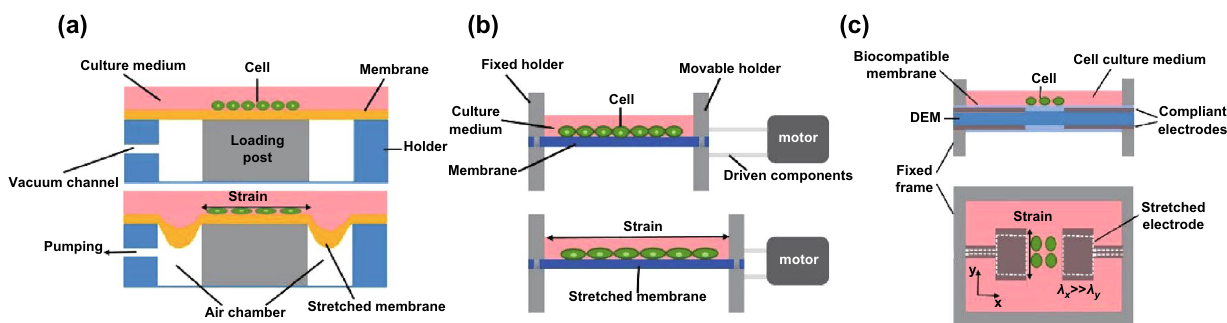
Fig. 8 Schematic of typical pneumatic, motor-driven, and the DEA-based device. a Side view of classic pneumatic cell stretching devices. An air chamber is formed by combining the membrane, holder, and loading post. Pumping air from the chamber can generate pressure difference that leads to absorption of membrane and stretch the cells. b Side view of motor-driven stretching devices. The membrane with seeded cells is matched with two holders: One is movable, while the other is fixed. The movable holder connects with motor through driven components (gears, track, etc.). Once control signal input to the motor, generated motion drags the holder, causing stretching strain as consequence. c Side and top views of DEA-based cell stretcher. The DEA is sandwiched by biocompatible membrane and then fixed by rigid frame